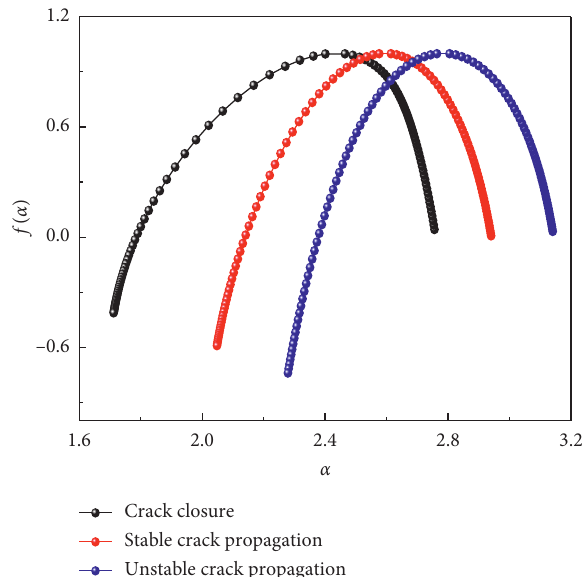
Figure 4: Multifractal spectrum at different